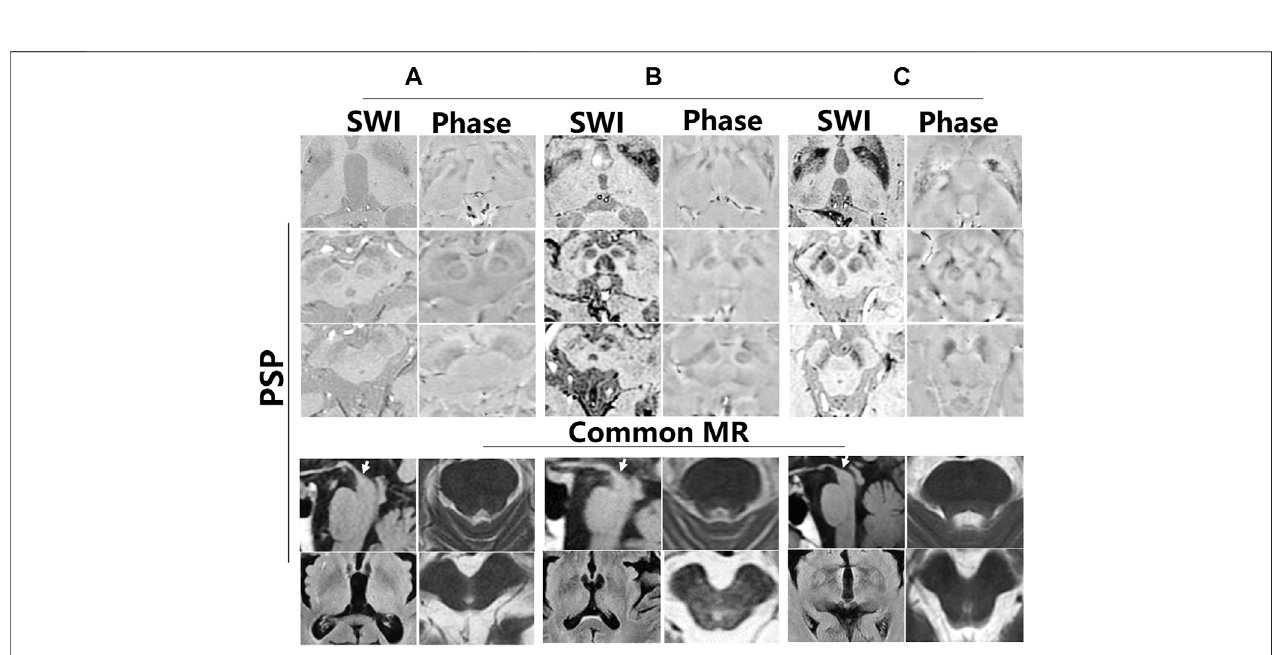
FIGURE 8 | Iron deposition in the substantia nigra and corpus striatum of progressive supranuclear palsy (PSP). (A – C) Different patients with PSP. There is a hummingbird sign on sagittal T1WI of the brain in these patients (white arrow).